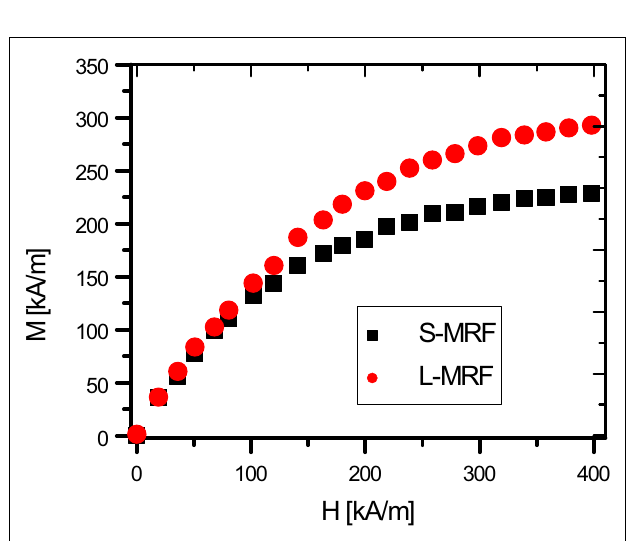
FIGURE 1 | Morphology of (A) the small-sized particle (B) the large sized particle, and (C) structural characterization of plate-like iron particles .